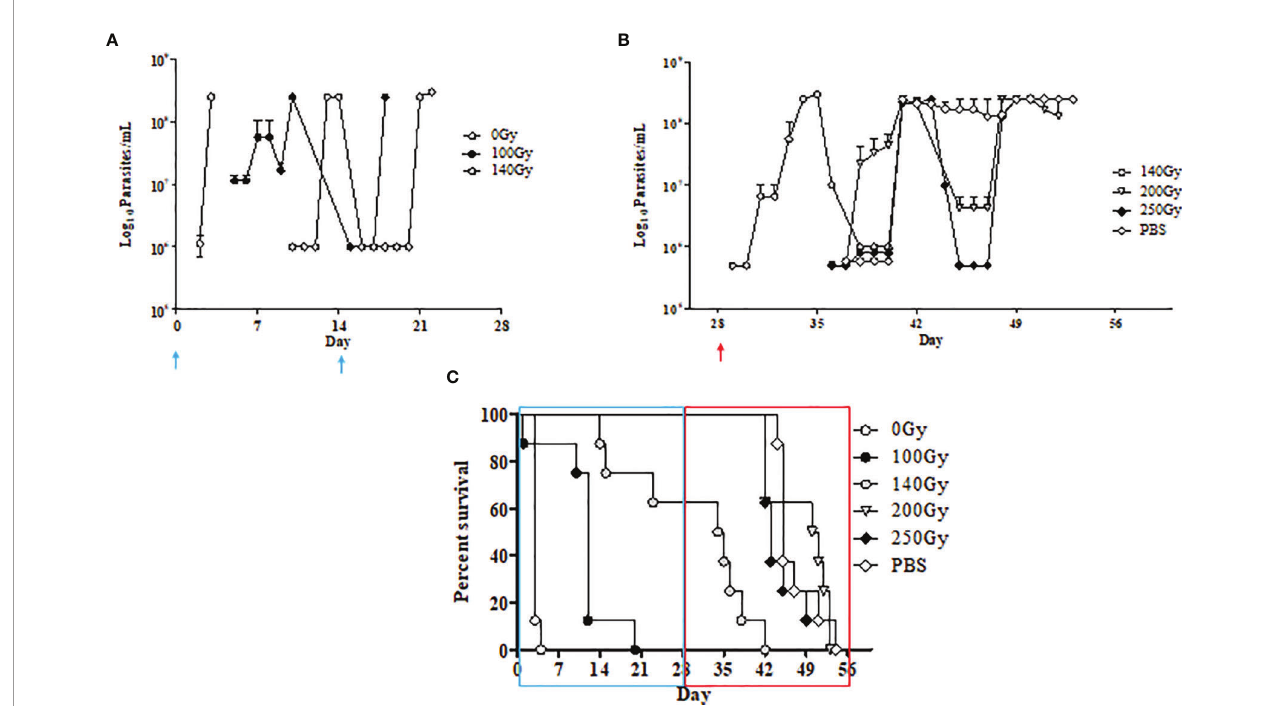
FIGURE 2 | In-vivo characteristics of irradiated parasites at different doses. (A) Parasite counts in mice that developed an infection after inoculation with T. evansi RoTaT1.2 irradiated parasites on days 0 and 14 ( ↑ ) are plotted. Mice in groups inoculated with either 0Gy or 100Gy irradiated parasites all developed parasitemia although with a delayed prepatent period at day 4 for mice inoculated with 100Gy irradiated parasites. Only three mice in the group inoculated with 140Gy irradiated parasites were infected with parasites fi rst appearing at day 9. (B) Parasite counts in mice that developed an infection after heterologous challenge with T. evansi